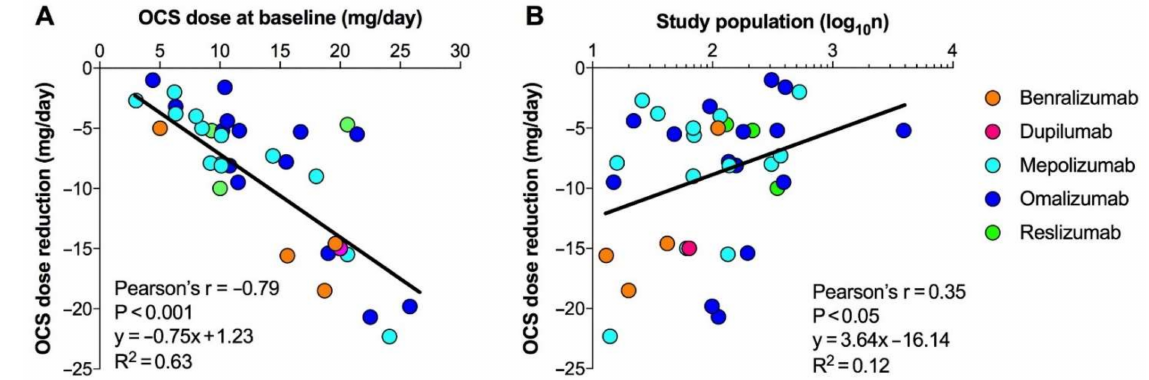
Figure 2. Linear regression and Pearson’s correlation analysis between the reduction in the dose of OCS induced by mAbs and the level of OCS dose at baseline ( A ) or the size of the study population ( B ); the dose of OCS was reported as prednisone equivalent. OCS: oral corticosteroids; mAb: monoclonal